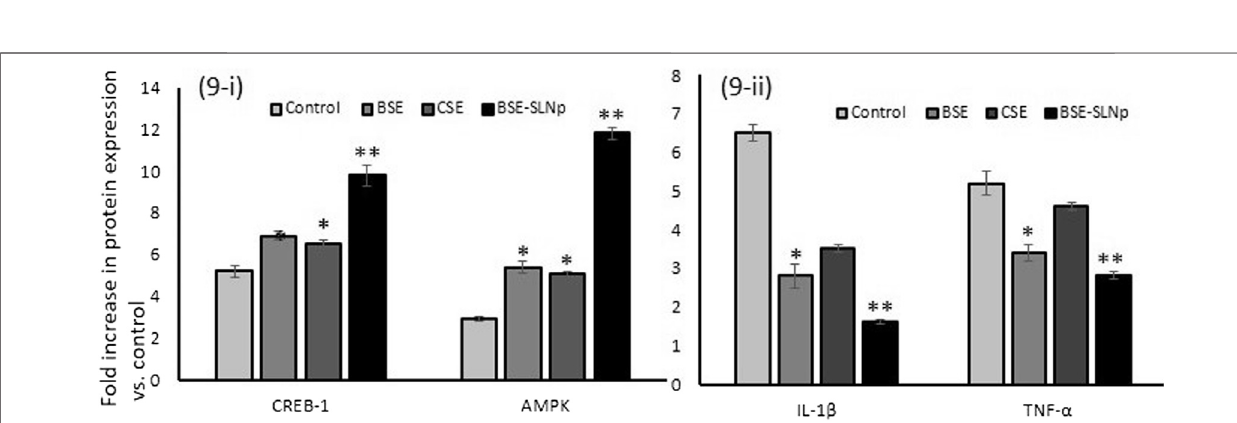
FIGURE 9 | Quanti fi cation of adipocyte energy metabolism (9i) and vascular cell in fl ammation (9ii) related protein levels in BSE, CSE, and BSE-SLNp treated maturingadipocyte(14 days)andHUVECs(2 days)usingtheELISAmethod.Eachvalueismeans ± SD( n (cid:2) 6).* p ≤ 0.05bycomparisonwithvehiclecontrol.** p ≤ 0.001 by comparison with vehicle control, BSE, and